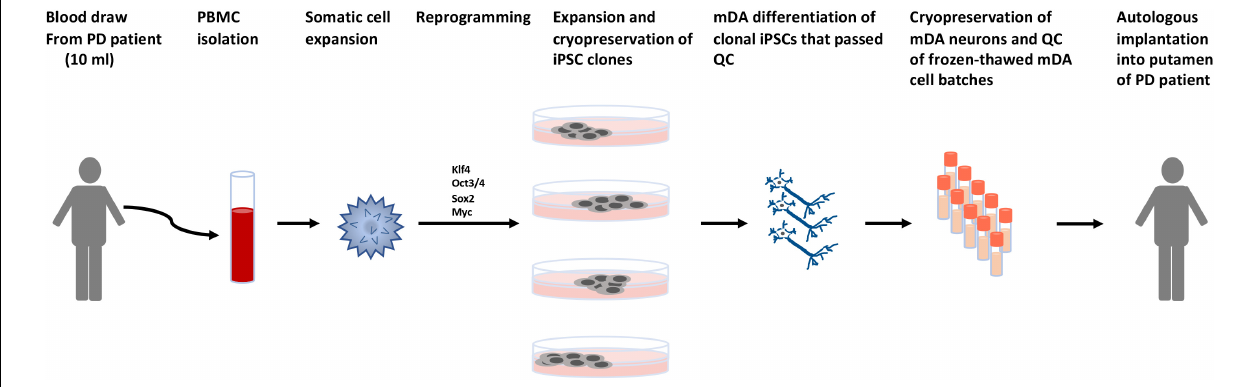
FIGURE 6 | Schematic describing the process for autologous cell therapy for Parkinson’s disease. Blood is collected from patients by venipuncture. Peripheral blood mononuclear cells (PBMCs) are isolated and the specific somatic cell population for reprogramming is expanded. Reprogramming factors (Takahashi et al., 2007) are introduced and clonal lines expanded for quality control testing. Clones that pass all quality control (QC) steps are used for mDA differentiations. The mDA neurons are cryopreserved and the batches quality control tested prior to autologous